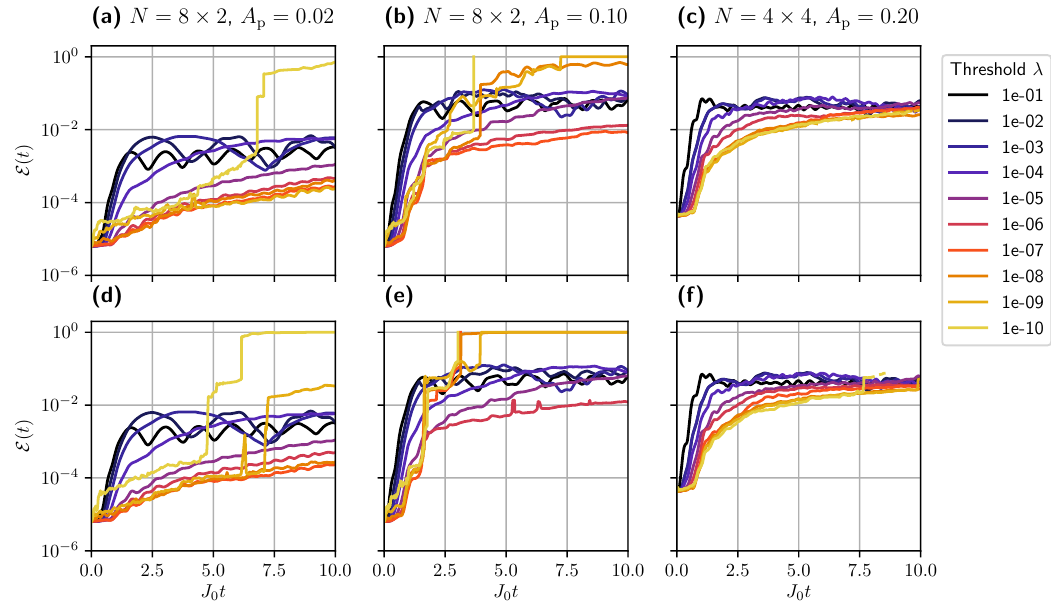
Figure 6: Infidelity of the time-evolved variational state compared to the exact trajec- tory for varying regularization (in the form of the SVD threshold λ ). The trajectories have been computed using t-VMC with EMC [ panels (a)–(c) ] and Metropolis [ panels = 0.02 [ panels (d)–(f) ] sampling. The columns correspond to a weak excitation A p = 0.10 [ panels (b),(e) ] in the 8 × 2 ladder, as (a),(d) ] and a moderate excitation A p = 0.20 in the 4 × 4 square lattice [ panels (c),(f) ] . The well as a stronger excitation A p ( t = 0 ) of order 10 − 5 is the approximation error of the variational ground initial E state. The time propagation has been computed using t-VMC with EMC sampling = 24000 samples for the ladder [ panels (a),(b) ] and N = 11200 for the with N s s square lattice [ panel (c) ] . We have used the symmetrized RBM ansatz with a hidden unit density of α =